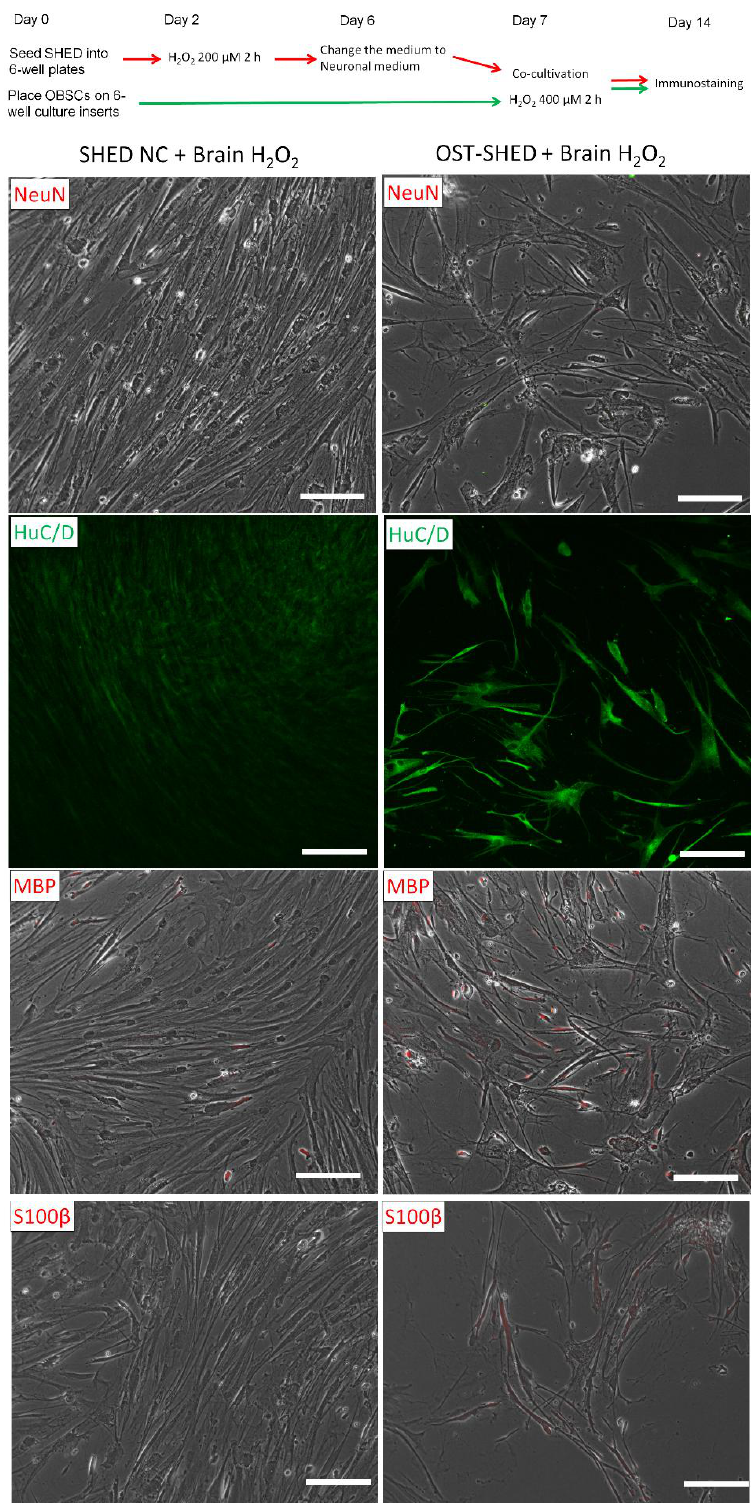
Figure 4. Auto-differentiation of OST-SHED. At the end of cultivation (day 14), co-cultivated SHED were subjected to immunostaining. The results showed that both normal SHED (SHED NC) and OST-SHED were negative to anti-NeuN antibody. SHED NC showed weak expression of HuC/D and MBP. S100β was absent in SHED NC. In contrast, OST-SHED showed much stronger expression of HuC/D, MBP and S100β.